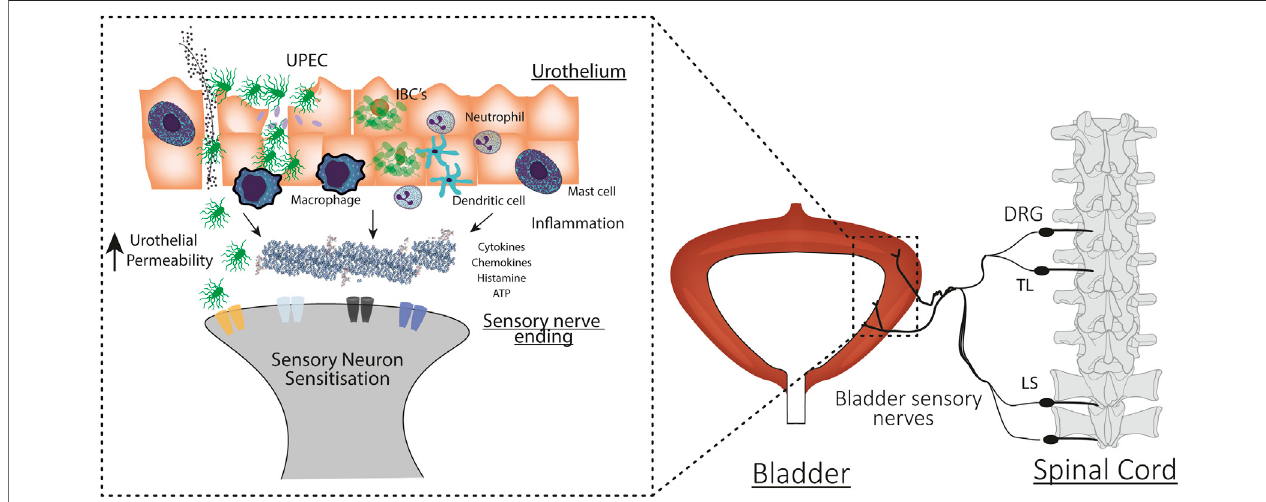
FIGURE 2 | Mechanisms underlying urinary tract infection induced bladder hypersensitivity. Uropathogenic E. coli (UPEC) invade urothelial cells during bladder colonisation. UPEC infection evokes an in fl ammatoryresponseand the recruitment and activation of immune cells. UPECalso form intracellular bacterial colonies (IBCs) to evade the immune system and prolong urothelial colonisation. UPEC infection induces urothelial sloughing and apoptosis, increasing bladder permeability and allowing the toxic contents of the urine and bacteria to access the underlying interstitium. In response to damage, immune cells and the urothelium also release cytokines, chemokines, and neurotransmitters that can bind to receptors and ion channels on the peripheral ends ofbladder-innervating sensory neurons. Immune and urothelial cell secretions, bacteria, and urine combine to sensitise the peripheral ends of bladder neurons. Sensitised neurons respond to bladder distension with higher intensity fi ring.Thisexaggeratedsignaltravelstothespinalcordandactivatessecondorderneuronsthattraveltothebrainstemandbraintoinduceexaggeratedbladder